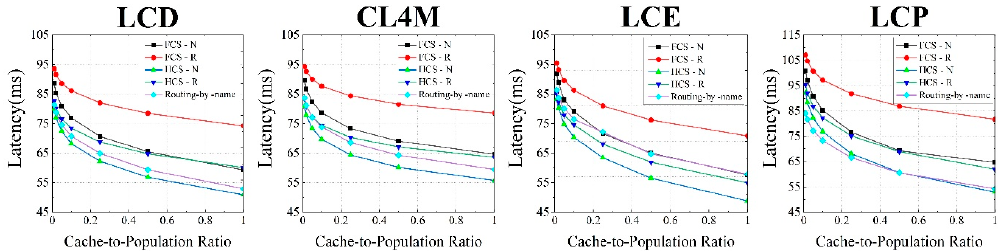
Figure 7. Comparison of latencies with cache-to-population ratios {0.01, 0.02, 0.05, 0.1, 0.25, 0.5, and 1}.